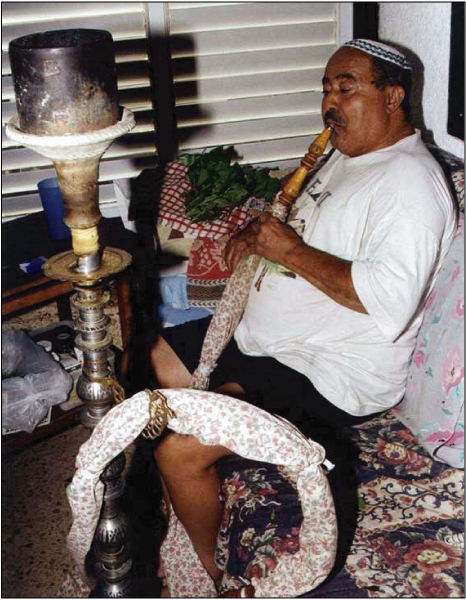
Chewing khat and smoking of the nargila.